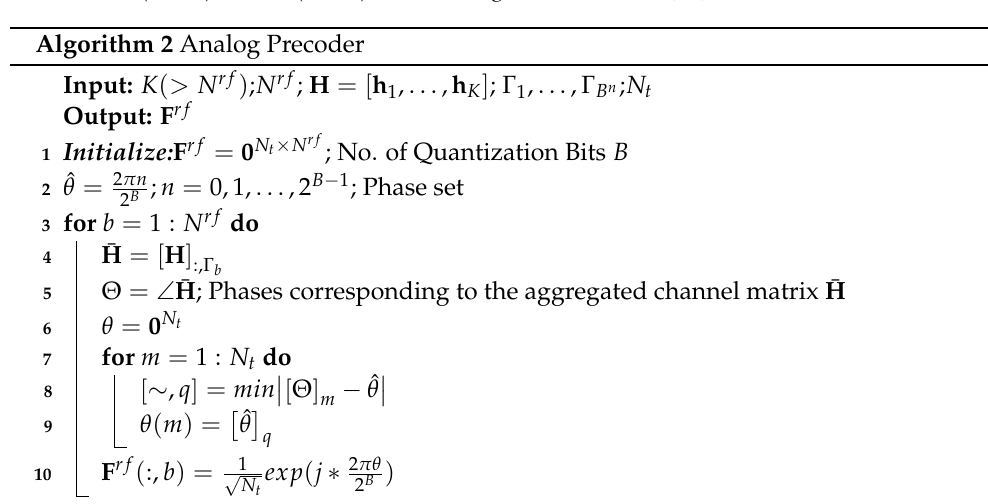
Algorithm 2 Analog